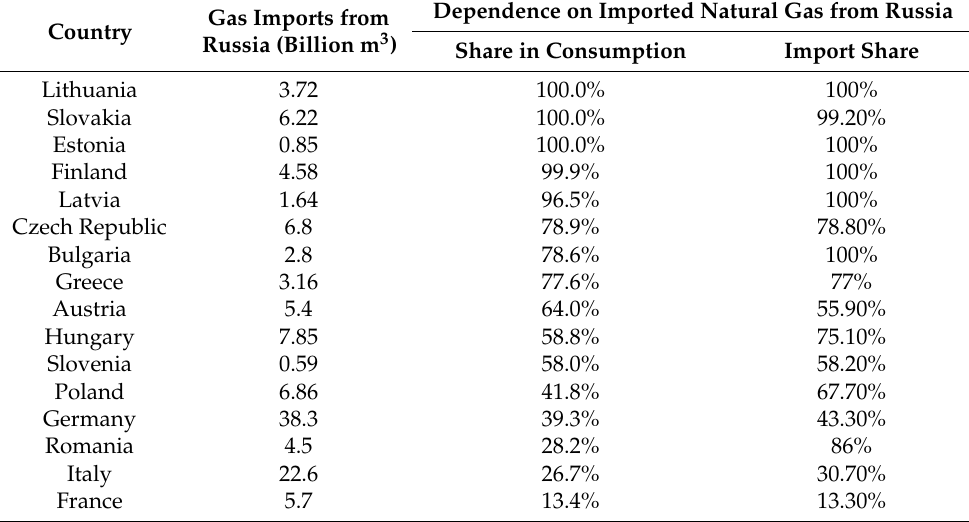
Table 2. The dependence of individual EU Member States on gas imports from Russia [41].